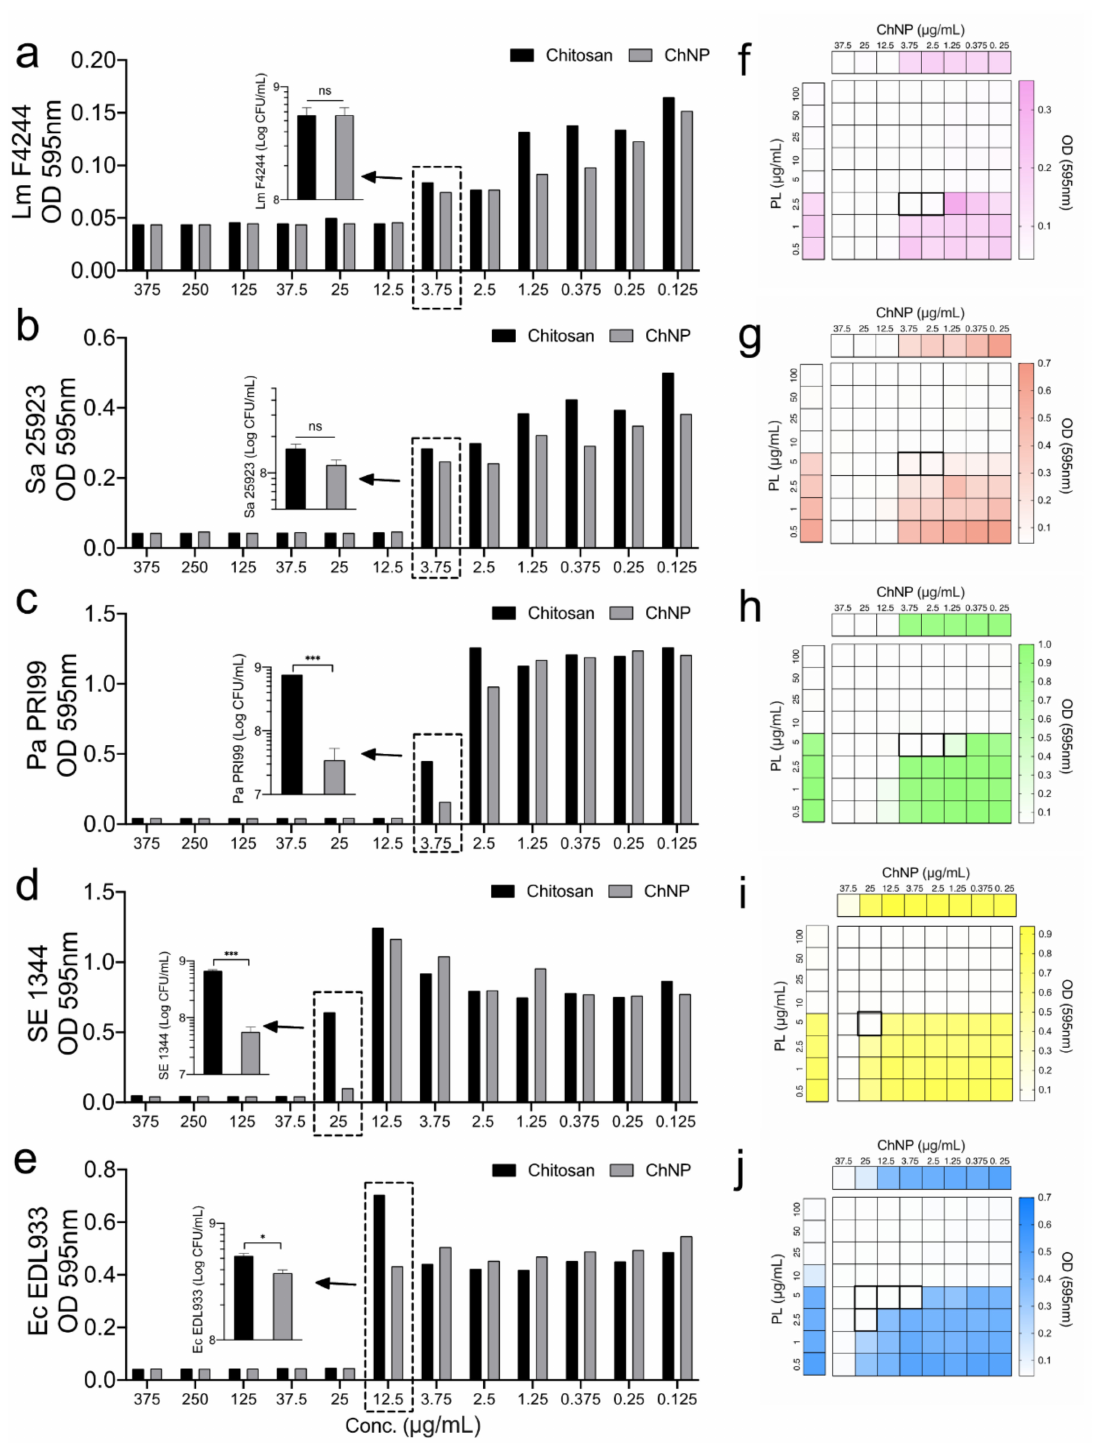
Figure 2. Comparison of the minimal inhibitory concentration (MIC) of chitosan and chitosan nanoparticles (ChNP) on ( a ) L. monocytogenes F4244 (Lm), ( b ) S. aureus ATCC25923 (Sa), ( c ) P. aeruginosa PRI99 (Pa), ( d ) S. Enteritidis 13ENT1344 (SE), and ( e ) E. coli EDL933 (Ec) in Mueller Hinton Broth (MHB). Synergistic MIC of ChNP and PL on ( f ) L. monocytogenes F4244, ( g ) S. aureus ATCC25923, ( h ) P. aeruginosa PRI99, ( i ) S. Enteritidis 13ENT1344, and ( j ) E. coli EDL933 was lower than the individual MIC of ChNP or PL. The boxes with bold boundaries indicate the reduced concentration of ChNP and PL when they act synergistically to the pathogens. A pairwise Student’s t- test was used for statistical analysis. * p < 0.05, *** p < 0.0005, ns, non